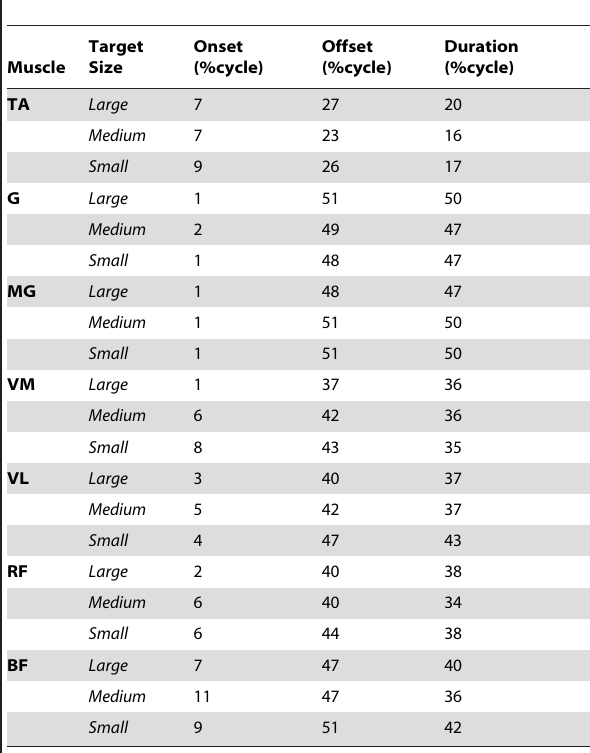
Table 1. Mean of EMG activity onset, offset, and duration during